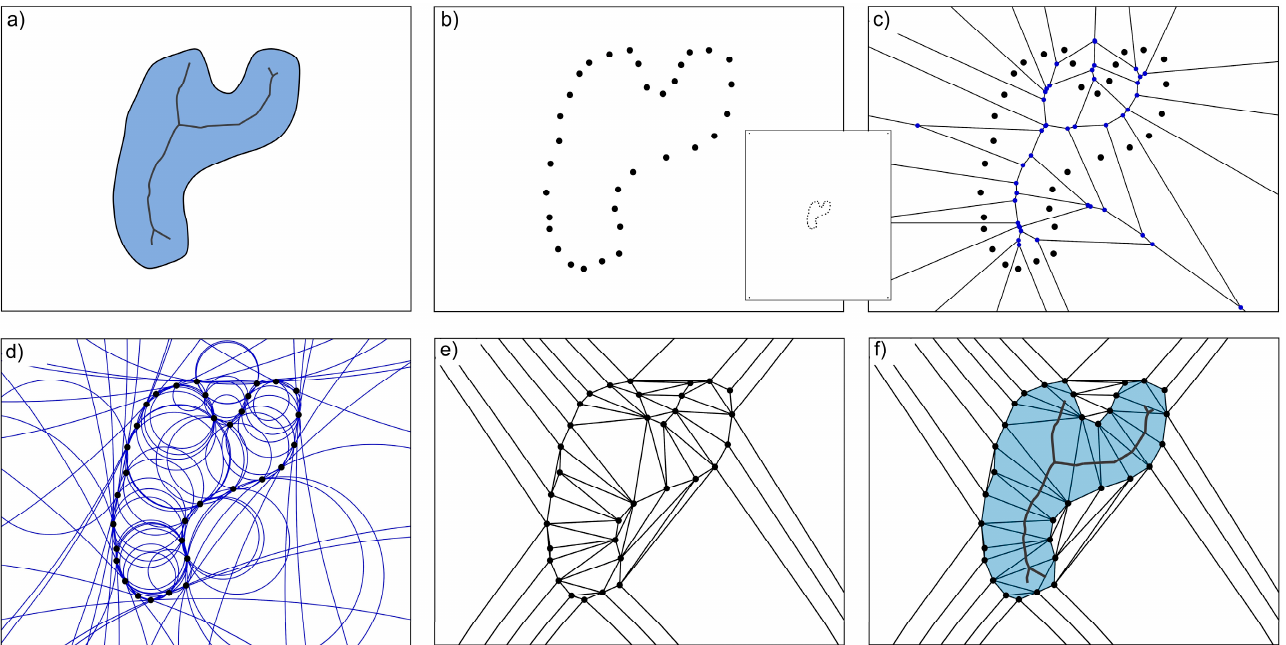
Figure 6. A 2D illustration of the Power Crust algorithm, adapted from Amenta et al. [55]; ( a ) the object with its medial axis; ( b ) the sampled point cloud, 𝑆 , with an inset image showing the 5-times bounding box points added to the samples; ( c ) the Voronoi diagram of 𝑆 , with Voronoi vertices, 𝑉 , plotted in blue; ( d ) maximal balls centered at the Voronoi vertices. The straight lines are a result of far outer polar balls with large radii such that they simplify to half-spaces intersecting the convex hull of 𝑆 , ( e ) Power diagram of 𝑉 , constructed with the weights of the maximal balls in (d). Polar balls within the envelope of another do not have their own Power cell, as they are overpowered; ( f ) the labelled Power diagram with the medial axis approximation. The boundary between the interior and exterior Power diagram cells is the Power Crust. Visualization adapted from Devert [64] and aided by the Scipy Spatial [66] and Matplotlib [67] libraries for Python.